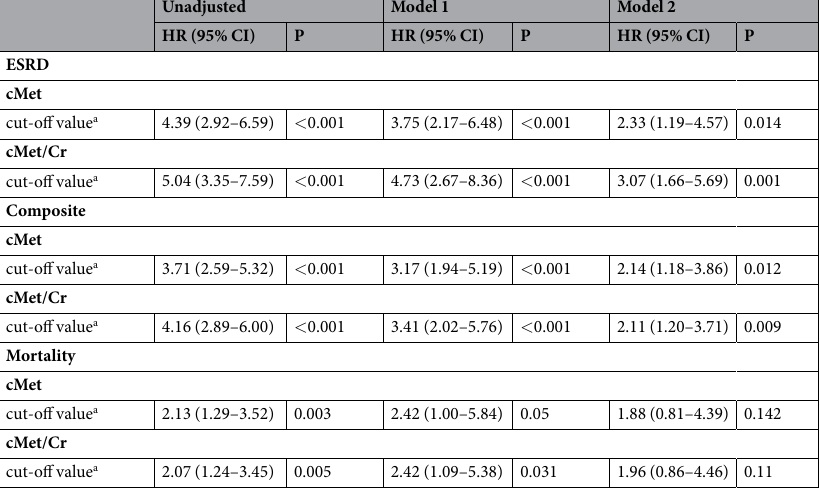
Table 2. Association of urine soluble cMet levels with graft failure and mortality using conventional Cox proportional hazards models. Multivariate Cox proportional hazard ratios. Model 1: adjusted for age, sex, hypertension, Hb, albumin, AST, ALT, uric acid, cholesterol, Ca, P, Model 2: adjusted for age, sex, hypertension, Hb, albumin, AST, ALT, uric acid, cholesterol, Ca, P, GFR, PCR HR, hazard ratio; CI, confidence interval. a Analyses were computed by including the predefined cut-off value of urine soluble cMet and cMet/Cr according to the ROC curve; both cut-off values were 2.9 ng/ml and 4.9 ng/mg with regard to mortality and end stage renal disease